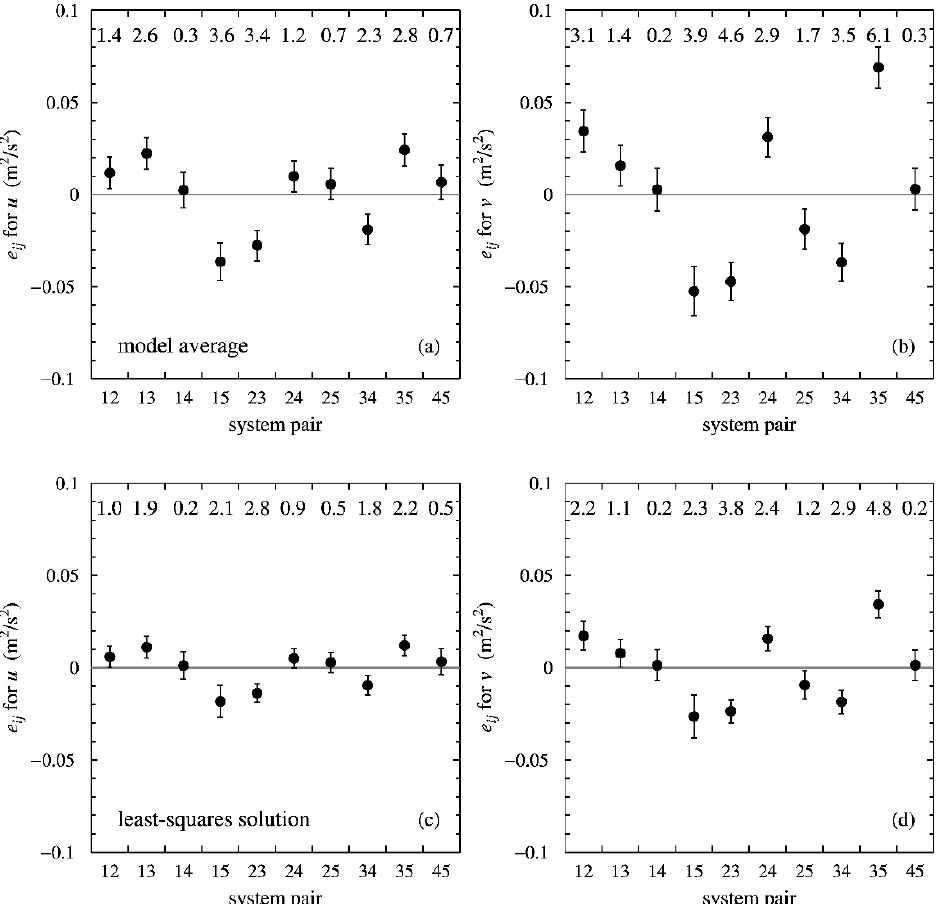
Figure 5. Error covariances and their accuracies from the model average for (cid:1873) ( a ), the model average for (cid:1874) ( b ), the least-squares solution for (cid:1873) ( c ), and the least-squares solution for (cid:1874) ( d ). The largest and positive error covariances are found for (cid:1857) (cid:2871)(cid:2873) , between ASCAT-A and ECMWF, in particular for (cid:1874) . Abdallah and De Chiara [4] also report error